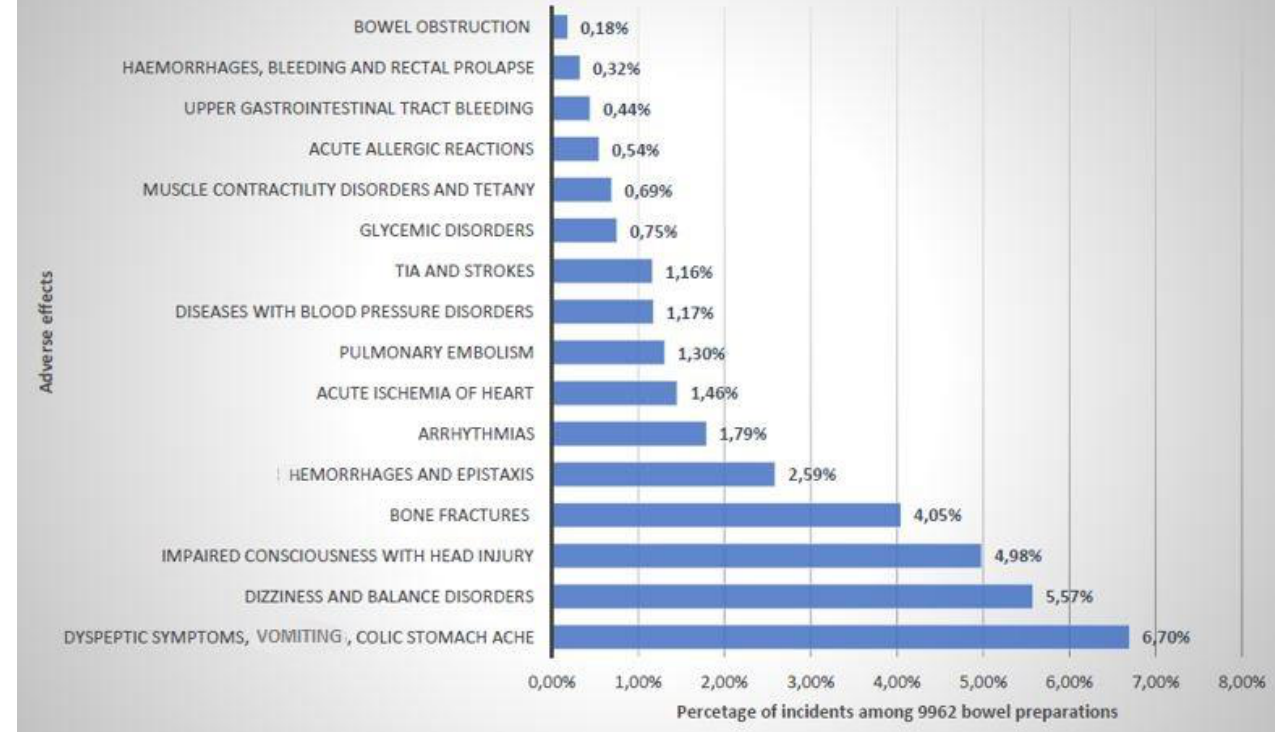
Figure 4. Prevalence of adverse effects occurring during the analysis of 9962 initiated bowel preparation regimens that required medical intervention at the ward and/or implementation of specialized medical procedures.